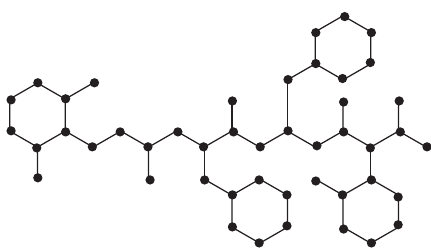
Figure 3: Molecular graph of